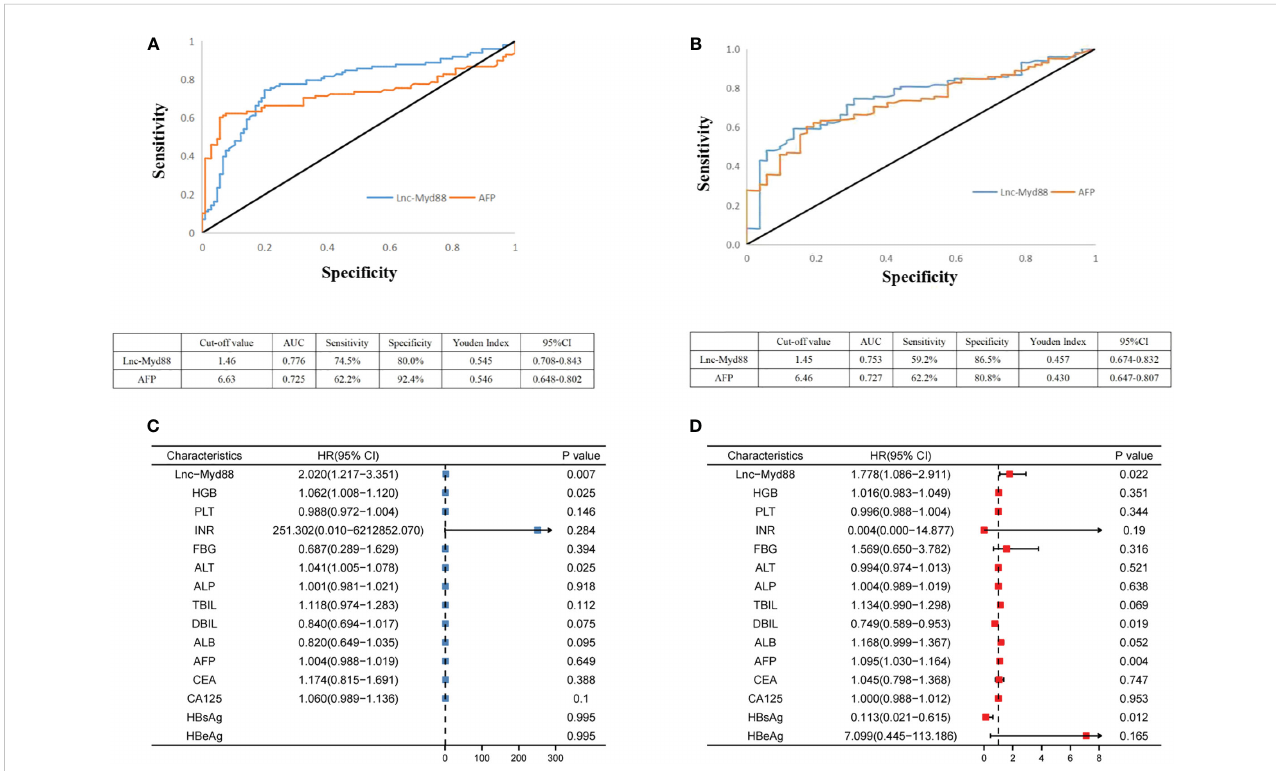
FIGURE 2 (A) ROC curve analysis of lnc-MyD88 and AFP expression in differentiating patients with HCC (n = 98) from healthy people (n = 105). (B) ROC curve analysis of lnc-MyD88 and AFP expression in differentiating patients with HCC (n = 98) from patients with LC (n = 52). (C) The multivariate analysis result indicated the diagnostic value of lnc-MyD88 for distinguishing healthy individuals from HCC patients. (D) The multivariate analysis result indicated the diagnostic value of lnc-MyD88 for distinguishing LC patients from HCC patients. LC, Liver cirrhosis; HCC, Hepatocellular carcinoma; HBV, Hepatitis B virus; Lnc-Myd88, Long noncoding RNA-Myd88; HBsAg, Hepatitis B surface antigen; HbeAg, Hepatitis B